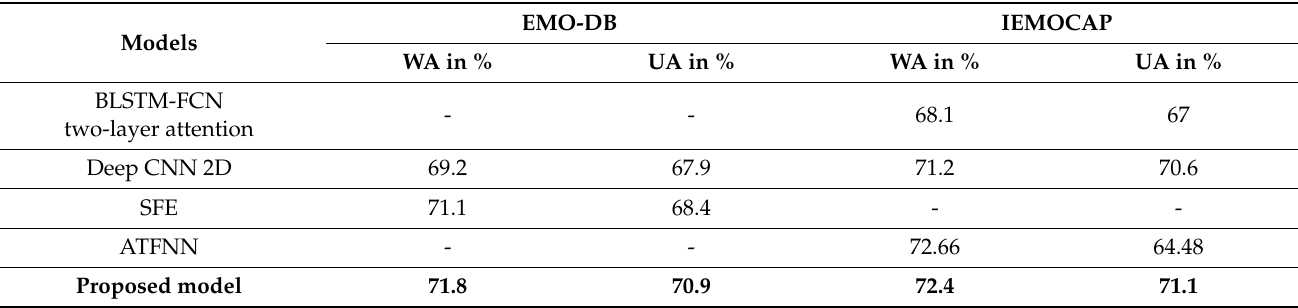
Table 2. Prediction performance and comparisons.